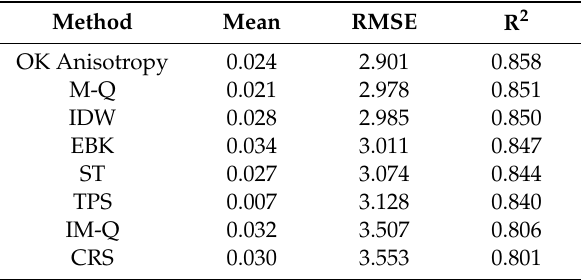
Table 1. Interpolation methods